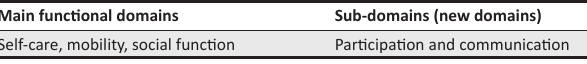
TABLE 4b: Identified functional domains. Main functional domains